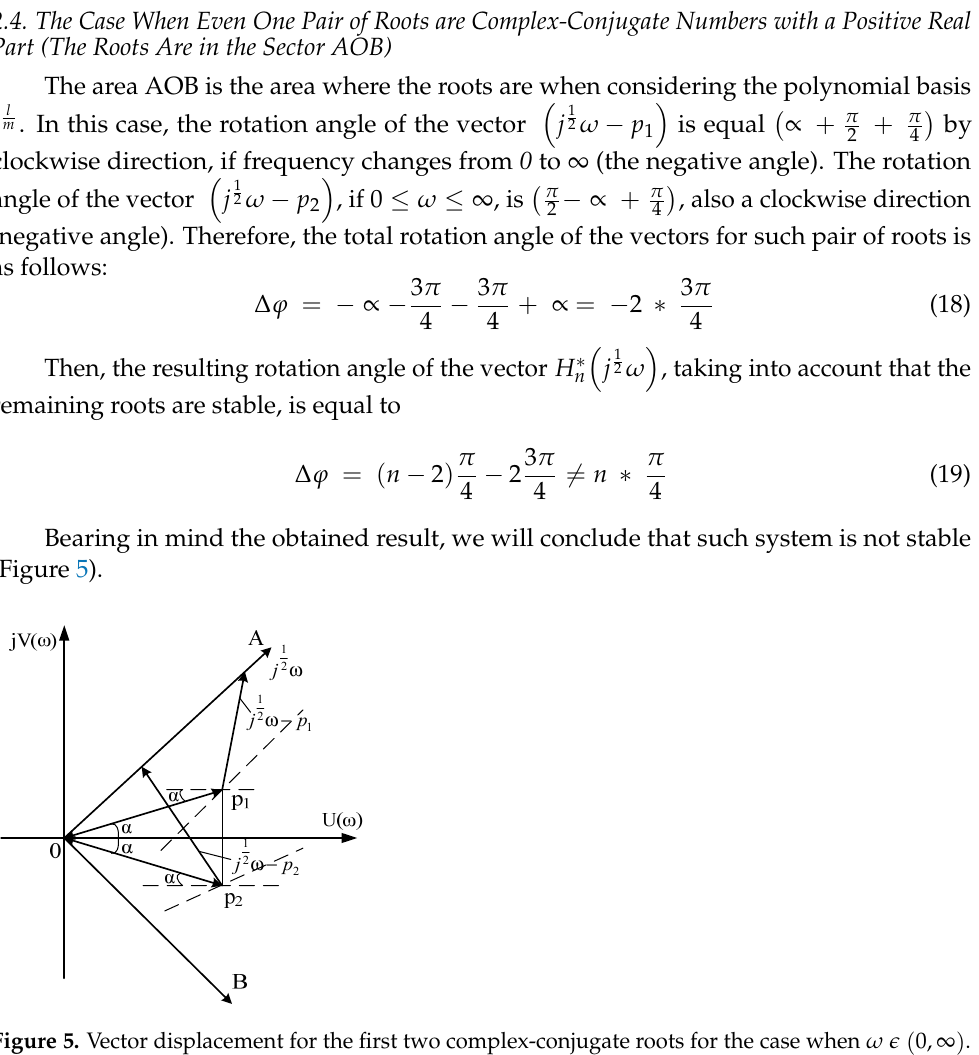
Figure 4. The transition function in this case.